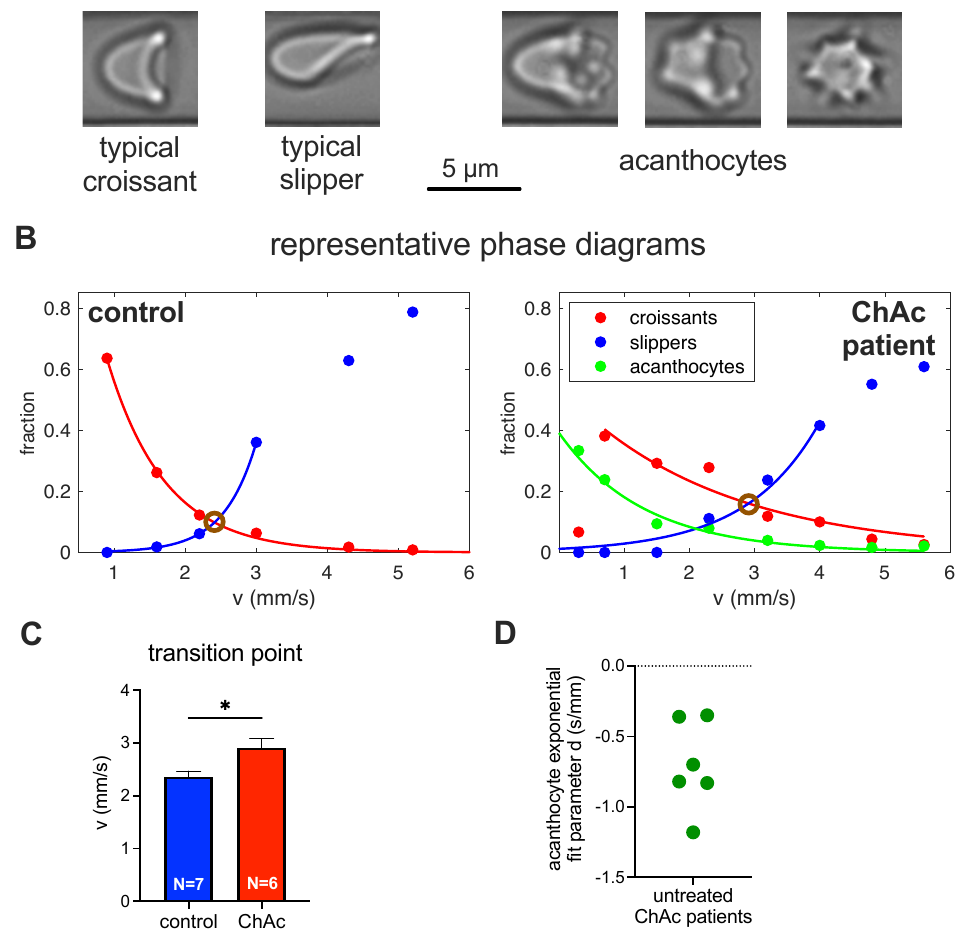
Figure 5. Investigation of RBC shapes in microfluidic flow. ( A ) Panel A shows the flow shapes of healthy RBCs (normocytes) on the left and a variety of acanthocytes on the right. ( B ) Panel B compares representative phase diagrams of a healthy control donor on the left and an (untreated) ChAc patient on the right, with the fitted exponential changes in the cell numbers. The transition point, where the number of croissants and slippers is identical, is marked with brown circles. ( C ) Panel C compares the transition points of a cohort of healthy controls and untreated ChAc pa-tients, indicating a higher rigidity of the normocytes in ChAc patients. * refers to a significance level of p < 0.05. ( D ) Panel D depicts the variance of the deformation parameter, d, of the acan-thocytes of different donors in